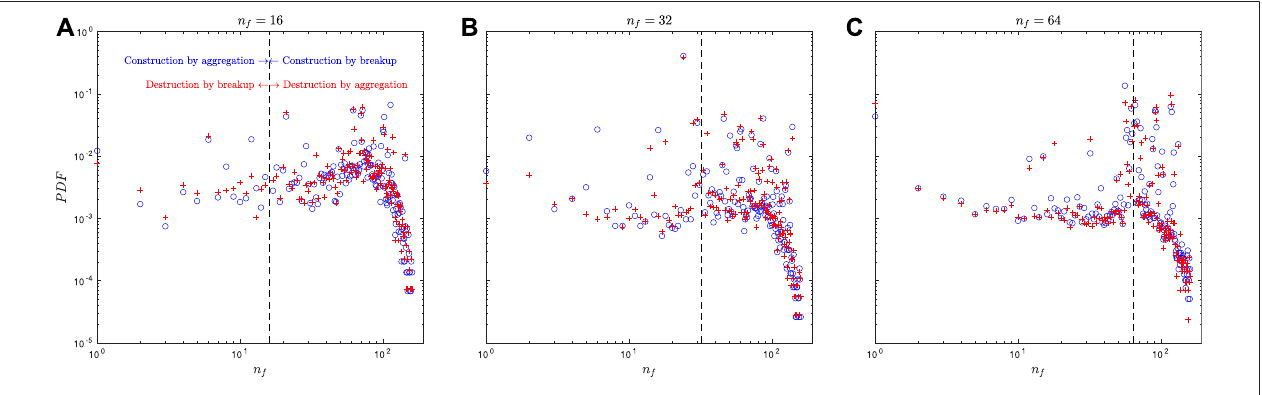
FIGURE7| Case P 2 S 1 withthelargeststickiness. (A) Probabilitydensityfunction(PDF)thata fl ocofsize n f becomesa fl ocofsize n f =16inanon-dimensionaltime period of 2 (blue circles) and the PDF that a fl oc of size n f = 16 evolves into a fl oc ofsize n f over the sameperiod (red pluses). (B,C) Same asframe-(A) for n f = 32 and 64.